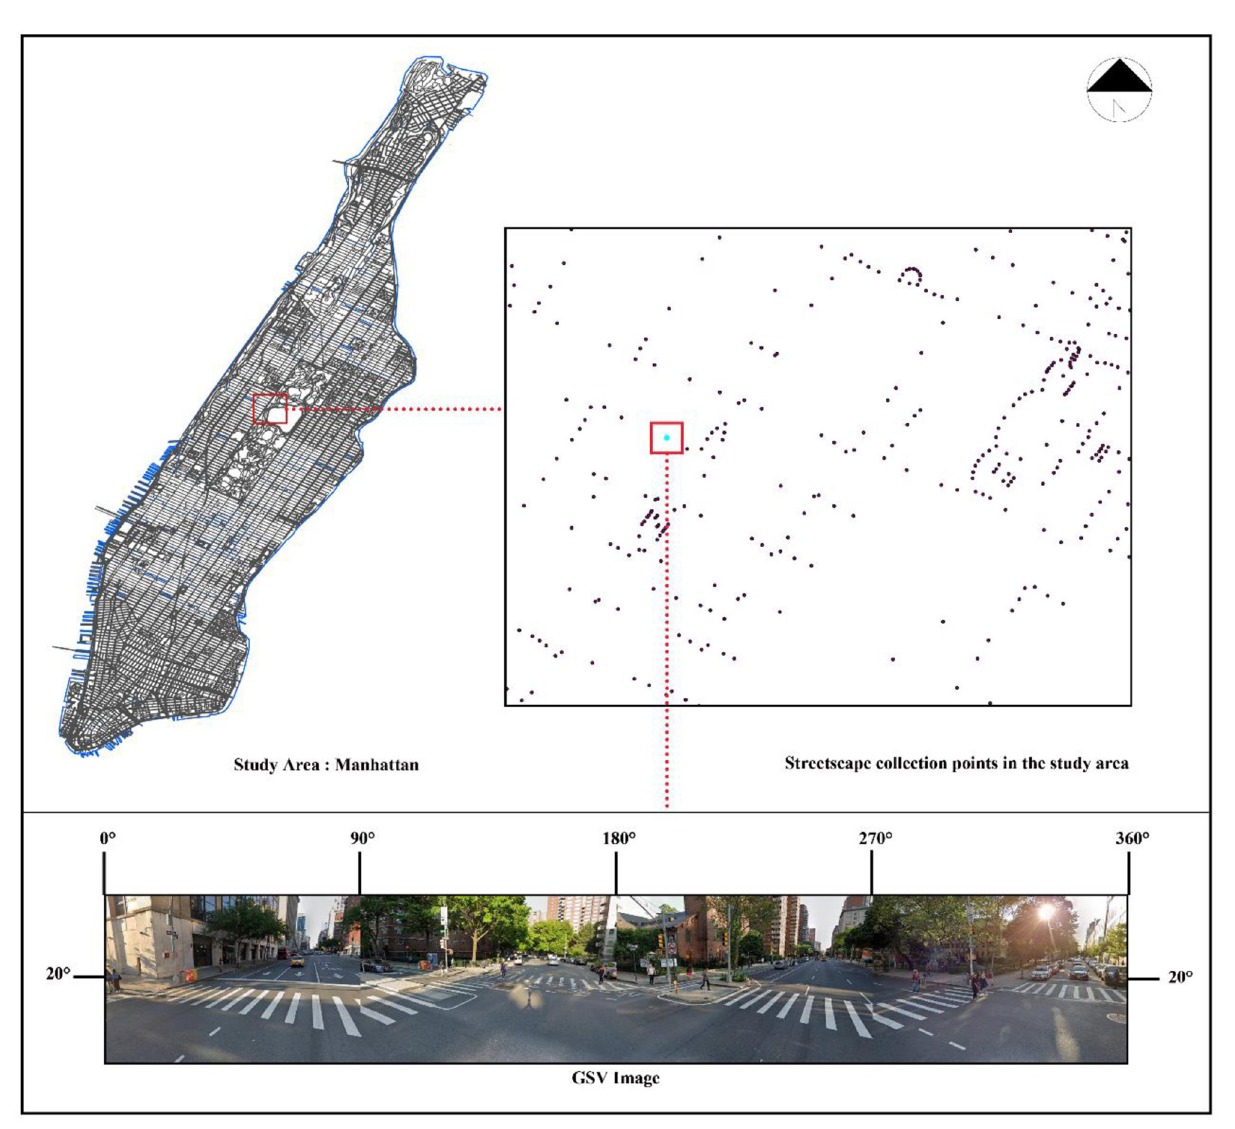
FIGURE2 Demonstration of the acquisition of GSV images.